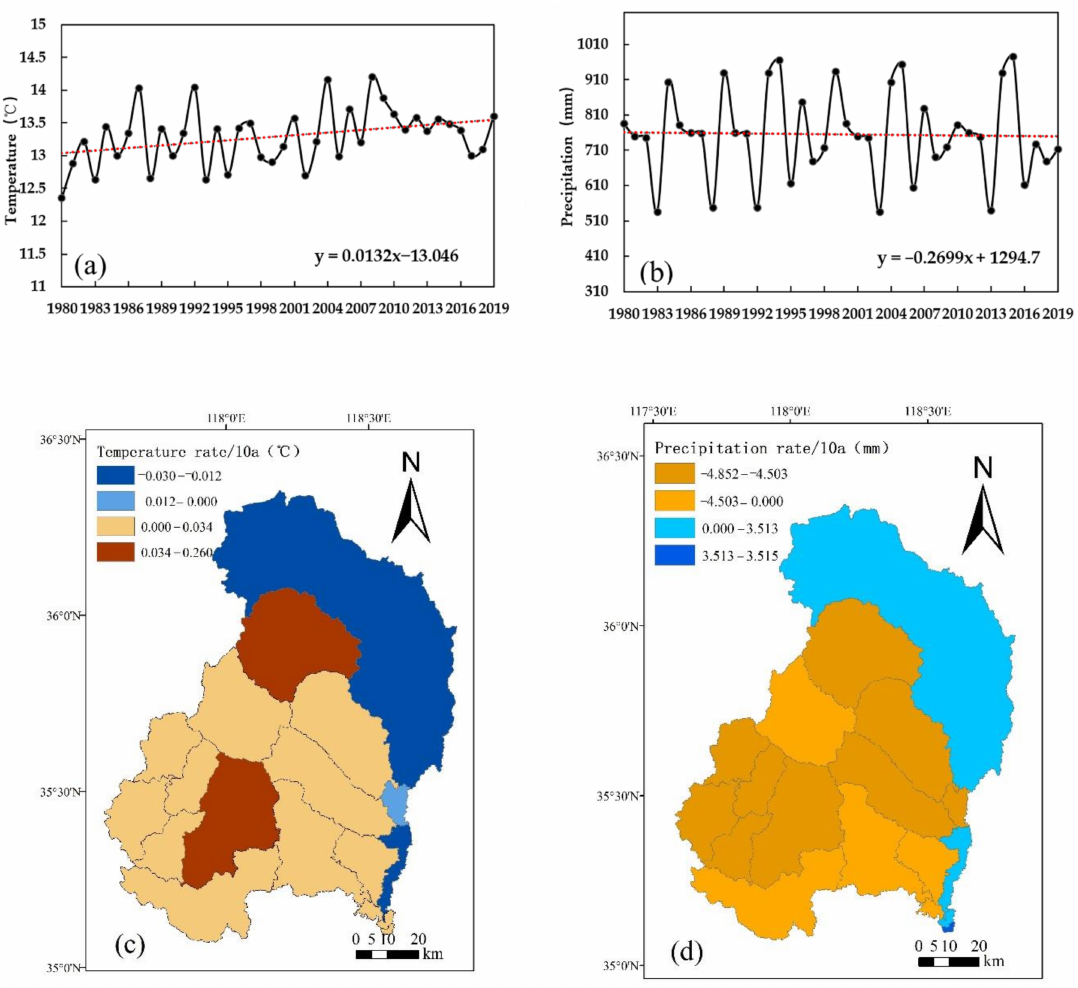
Figure 5. Temporal ( a , b ) and spatial ( c , d ) changes in the annual average temperature and precipitation in the 18 watersheds of the Yihe River from 1980 to